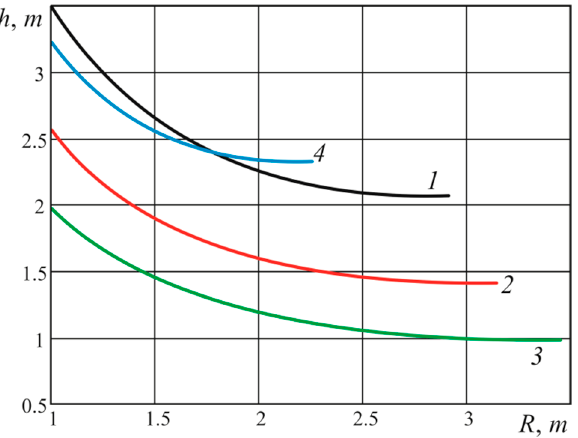
Figure 4. Determination of the circular recess drilling interval: 1—siltstone, 2—stone sandstone, 3—fine-grained limestone, 4—dolomite.